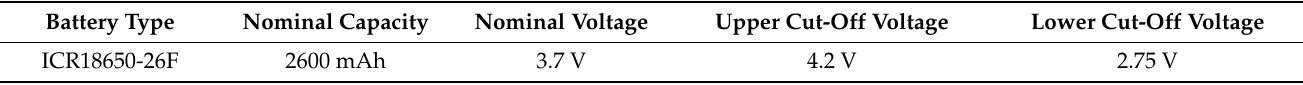
Table 3. The battery specification description.